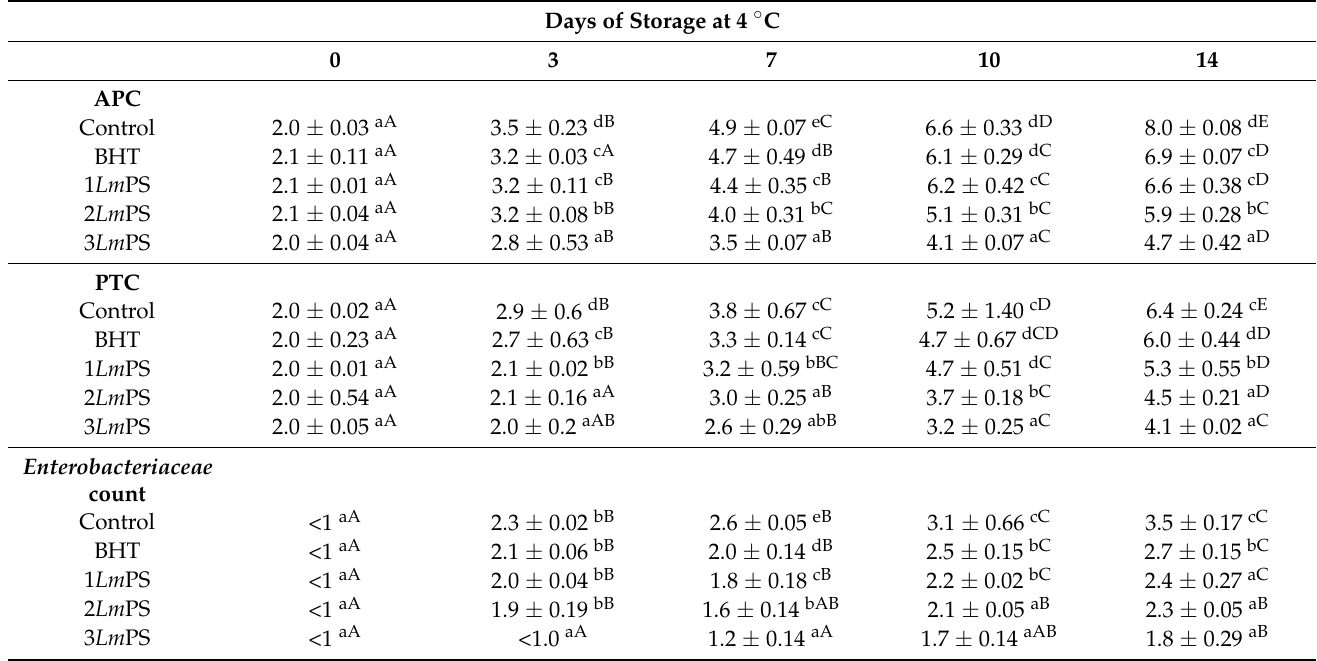
Table 4. Lm PS effect on the microbial load of aerobic plate count (APC), psychrotrophic count (PTC), and Enterobacteriaceae count of crude minced meat beef stored at 4 ◦